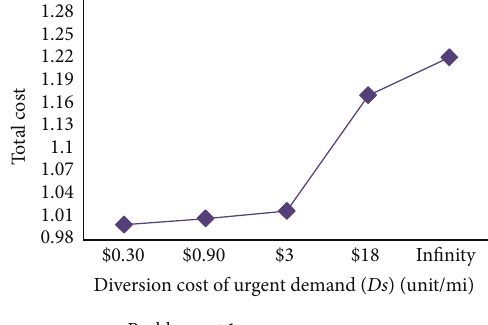
Figure 9: Relative total cost against different diversion cost per mile for urgent demand under MP policy, problem set 1. Note: total costs are represented relative to the cost where diversion cost per mile for urgent demand is equal to